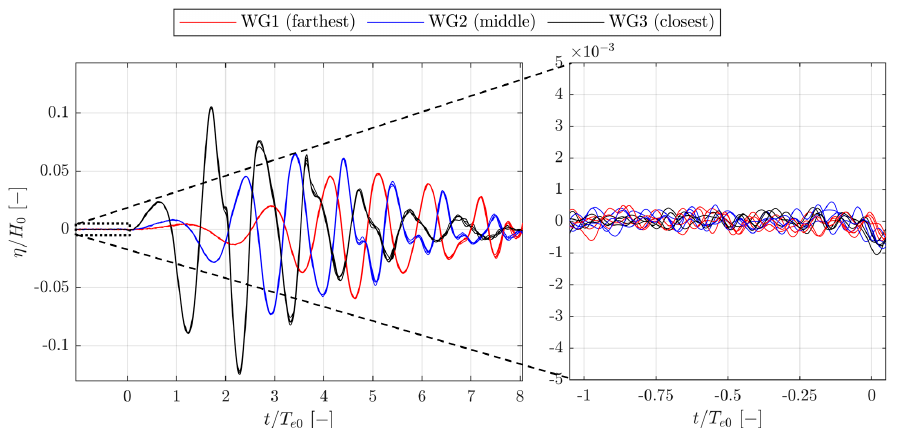
Figure 20. Surface elevation time series with a zoom of the limits − 1 < t / T e 0 < 0 for H 0 = 0.5 D .